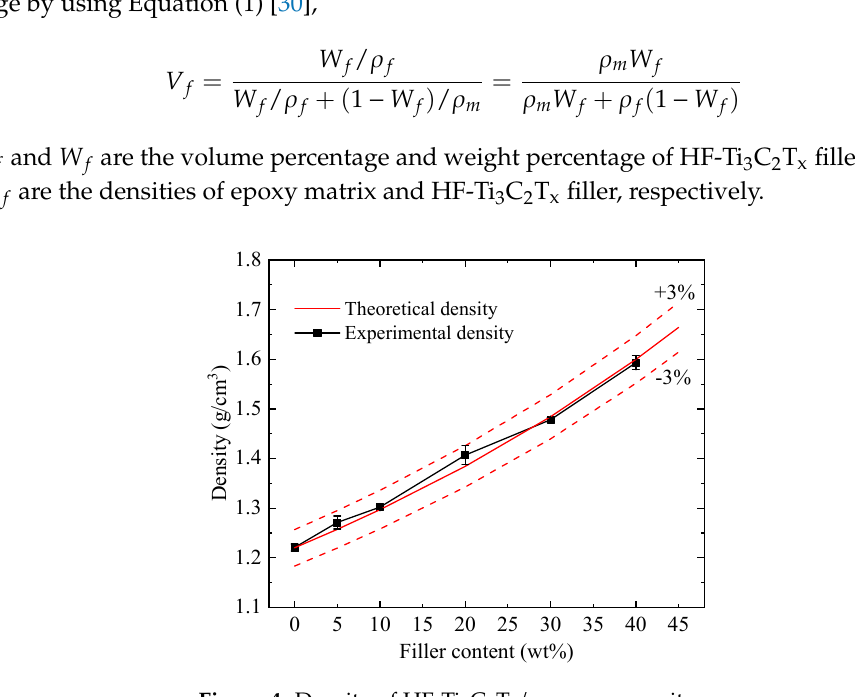
Figure 4. Density of HF-Ti 3 C 2 T x /epoxy composites.